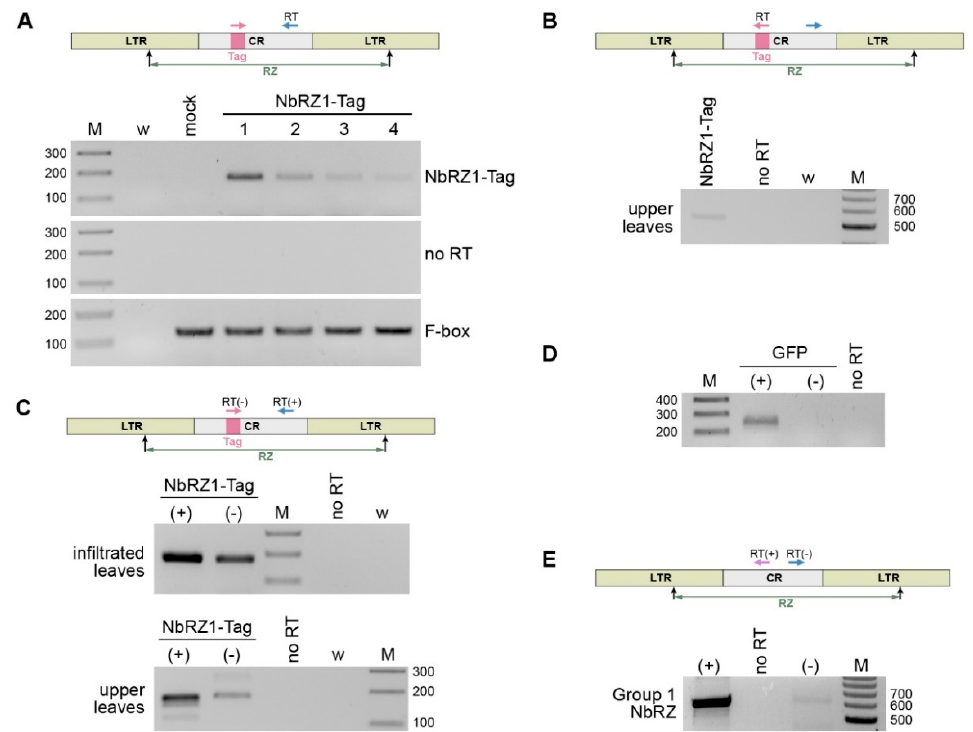
Figure 4. Systemic transport and replication of NbRZ1-Tag in N. benthamiana plants. ( A ) Reverse transcription-PCR analysis of the upper non-infiltrated leaves of plants, the lower leaves of which were agroinfiltrated for the expression of NbRZ1-Tag. Samples of four agroinfiltrated plants (numbered 1 to 4) and a non-infiltrated plant taken as a negative control (mock) were analyzed. Specificity of primers is indicated on the right. F-box primers were used as a control. No RT—amplification carried out without reverse transcription. W (water)—a control PCR without template added. M—DNA size markers. ( B ) Detection of circular/concatemeric NbRZ1-Tag RNA in the upper non-infiltrated leaves of plants, the lower leaves of which were agroinfiltrated for the expression of NbRZ1-Tag. Detection was carried out with a pair of divergent primers, one of which was specific for the tag. Location of the tag is shown on the retrozyme schematic representation above the gel; positions of primers are indicated by arrows. RT indicates the primer used for reverse transcription. ( C ) Detection of (+) and ( − ) RNA strands of NbRZ1-Tag in leaves infiltrated with agrobacteria carrying the NbRZ1-Tag construct and in upper non-infiltrated leaves. Reactions specific for (+) and ( − ) strands are indicated above the gel. The location of tag is shown on the retrozyme schematic representation above the gel; positions of primers are indicated by arrows. RT(+) and RT( − ) indicate primers used for reverse transcription carried out for detection of the (+) and ( − ) strands of NbRZ1-Tag RNA, respectively. ( D ) Detection of (+) and ( − ) RNA strands of GFP transcript in leaves agroinfiltrated for GFP expression. One pair of GFP-specific primers was used for detection of both strands, with reverse and forward primers being used for reverse transcription carried out for detection of (+) and ( − ) GFP strands, respectively. ( E ) Detection of (+) and ( − ) RNA strands of circular/concatemeric Group 1 retrozymes in leaves of N. benthamiana plants. Detection was carried out with a pair of divergent primers. Positions of primers are shown by arrows on the retrozyme schematic representation above the gel. RT(+) and RT( − ) indicate primers used for reverse transcription carried out for detection of the (+) and ( − ) strands of retrozyme RNA, respectively. No RT—PCR carried out on the same RNA sample without reverse transcription. W (water)—a control PCR without template added. M—DNA size